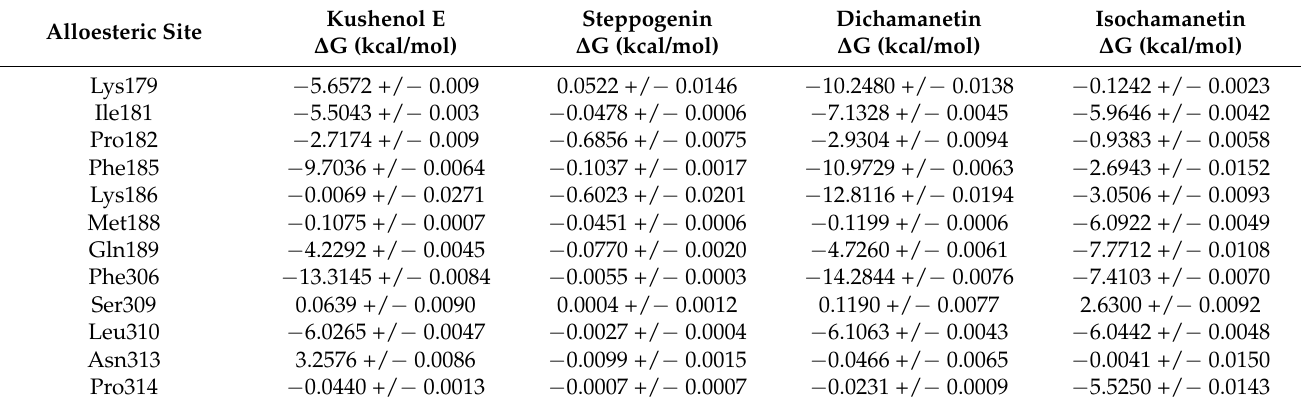
Table 4. Distributed binding energies per amino acid for each modeled IDO1-flavonoid